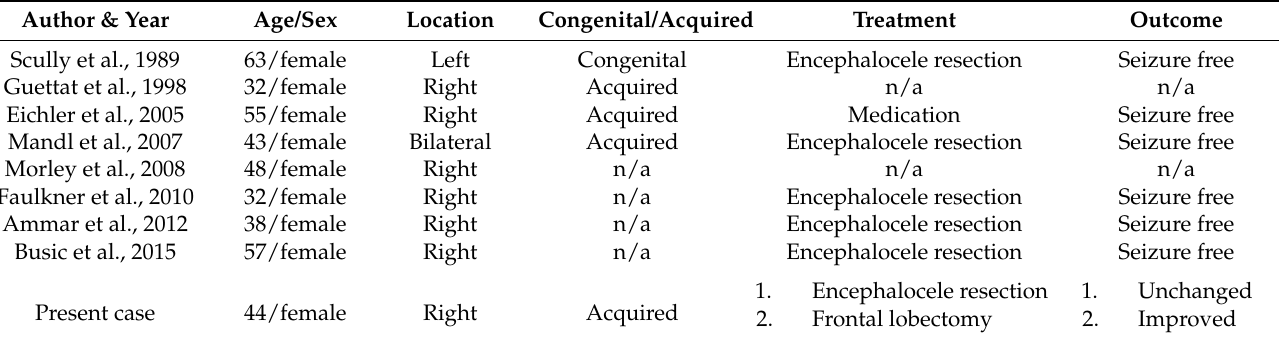
Table 1. Reported cases of epilepsy due to frontal